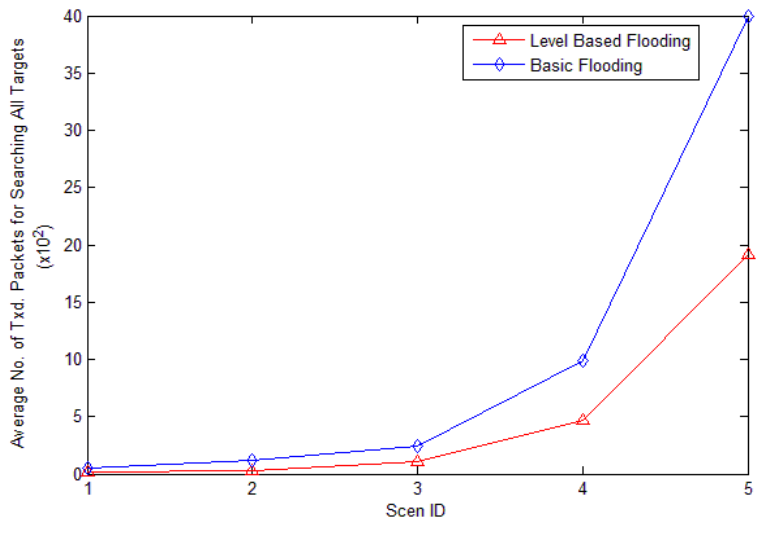
Figure 24. Average cost of search to find target